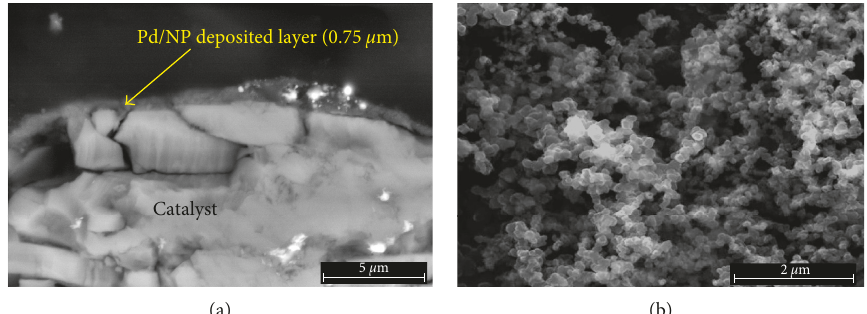
Figure 2: (a) Catalyst cross section after Pd/NP deposition; (b) Pd/NP deposited on the catalyst surface (after gold